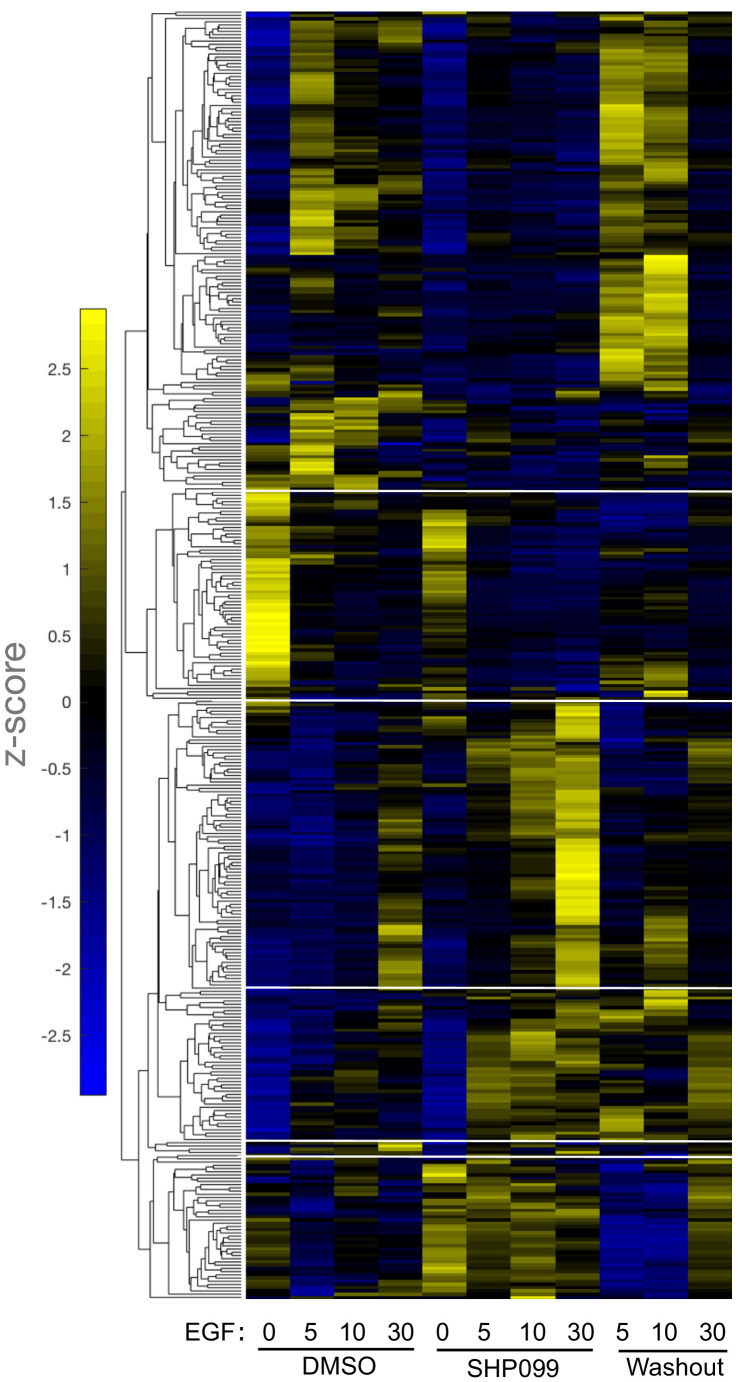
Kinetic pattern of pY response to EGF stimulation under DMSO, SHP099, and washout conditions.The heatmap shows six different response patterns, based on hierarchical clustering. Source data listing pY sites present in each hierarchical cluster are provided.Figure 2—figure supplement 1—source data 1.Annotated heat maps for proteins in cluster 1.Figure 2—figure supplement 1—source data 2.Annotated heat maps for proteins in cluster 2.Figure 2—figure supplement 1—source data 3.Annotated heat maps for proteins in cluster 3.Figure 2—figure supplement 1—source data 4.Annotated heat maps for proteins in cluster 4.Figure 2—figure supplement 1—source data 5.Annotated heat maps for proteins in cluster 5.Figure 2—figure supplement 1—source data 6.Annotated heat maps for proteins in cluster 6.Figure 2—figure supplement 1—source data 7.Alphabetical list of proteins in cluster 1, with pY sites as indicated.Figure 2—figure supplement 1—source data 8.Alphabetical list of proteins in cluster 2, with pY sites as indicated.Figure 2—figure supplement 1—source data 9.Alphabetical list of proteins in cluster 3, with pY sites as indicated.Figure 2—figure supplement 1—source data 10.Alphabetical list of proteins in cluster 4, with pY sites as indicated.Figure 2—figure supplement 1—source data 11.Alphabetical list of proteins in cluster 5, with pY sites as indicated.Figure 2—figure supplement 1—source data 12.Alphabetical list of proteins in cluster 6, with pY sites as indicated.